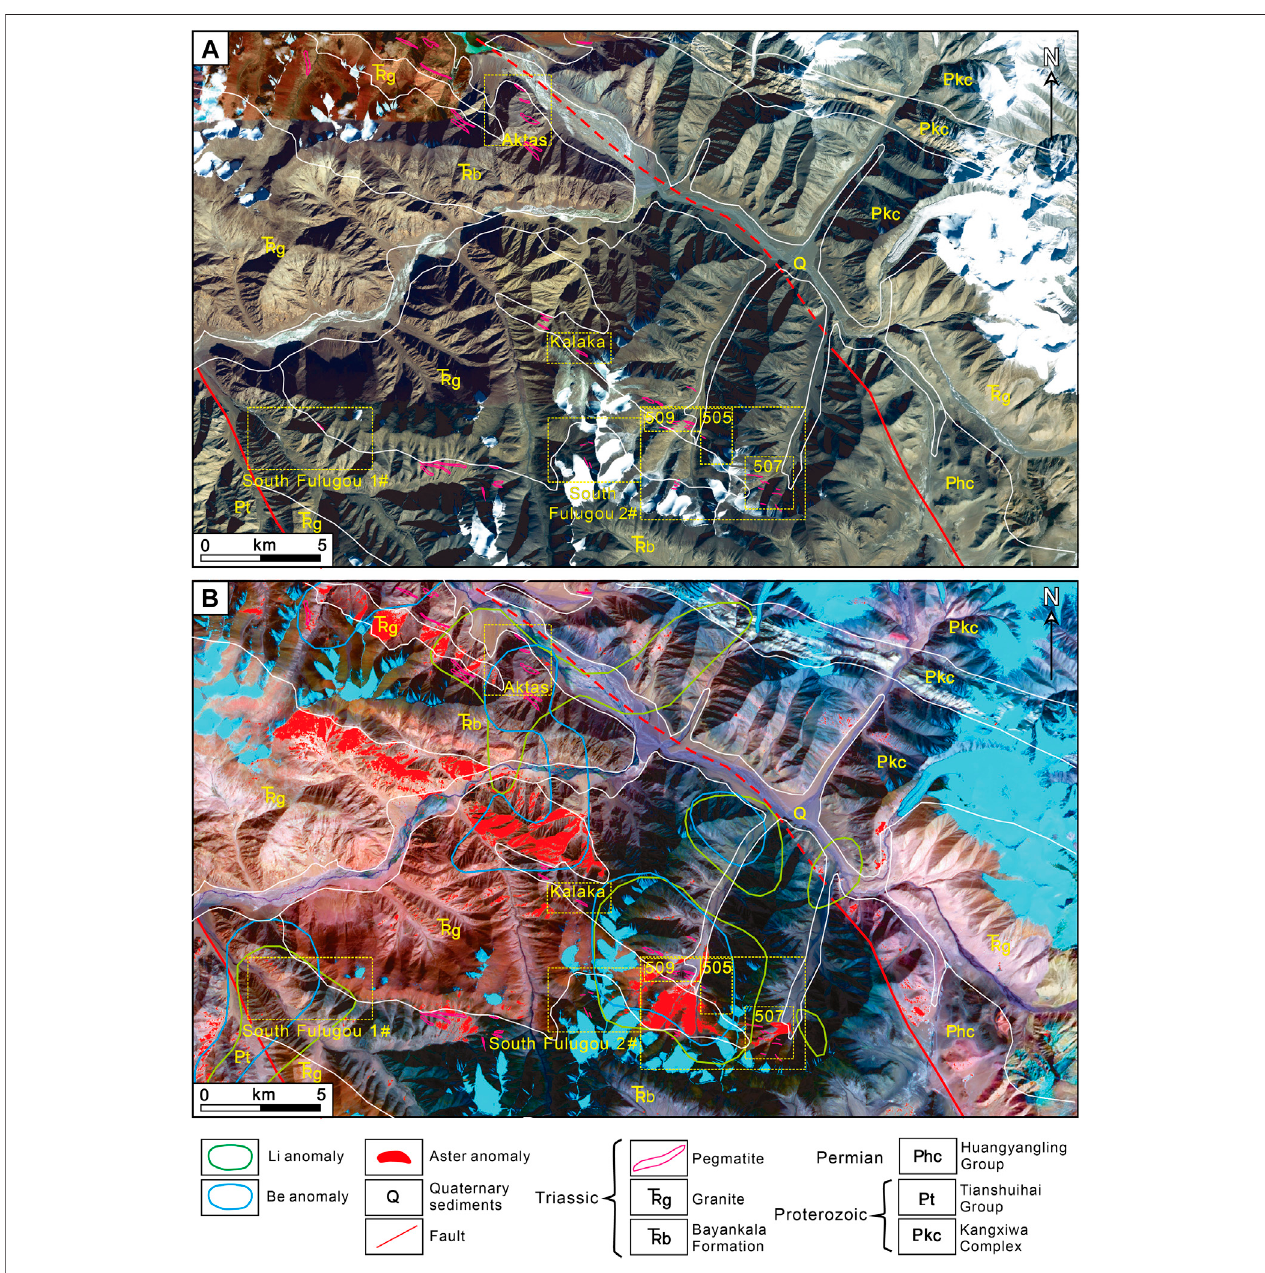
FIGURE 5 | Remote sensing images and prospective sites of Li mineralisation in the Dahongliutan area: (A) Worldview-2 image; and (B) Aster image, and geochemical anomalies of Li and Be.